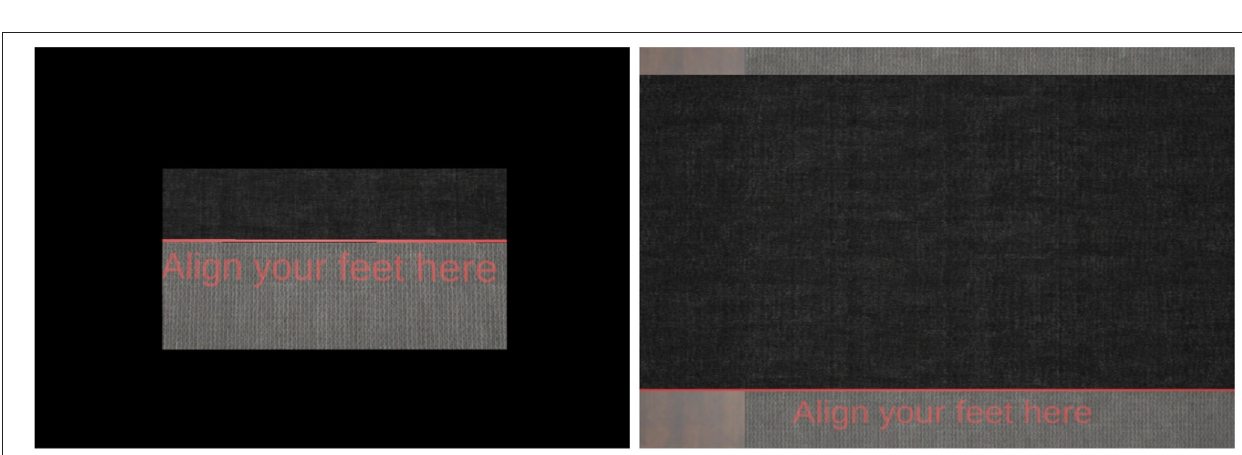
FIGURE 7 | Experiment 3 FOV conditions. The image on the left displays an example of a gap viewed in the Narrow FOV condition. The image on the right shows an example of a gap viewed in the Wide FOV